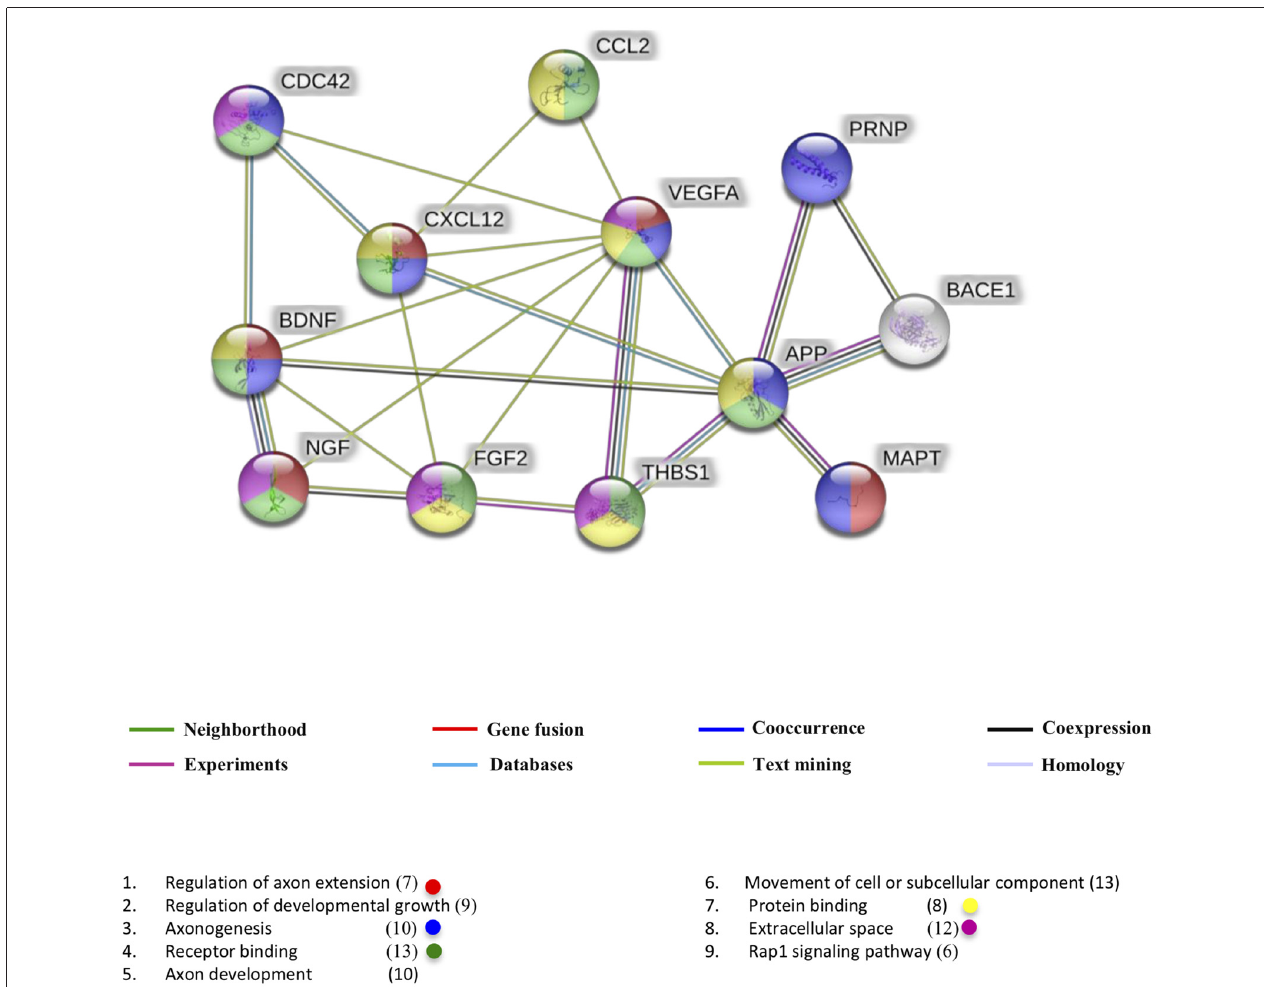
FIGURE 2 | Interactome of polypeptides found in common exosomes related with a beta and tau protein. UniProtKB accession numbers were submitted to the String program to identify the predicted functional network. Lines in color represent different pieces of evidence for each identified interaction: red line, fusion; green line, neighborhood; blue line, cooccurrence; purple line, experimental; yellow line, text mining; light blue line, database; black line,